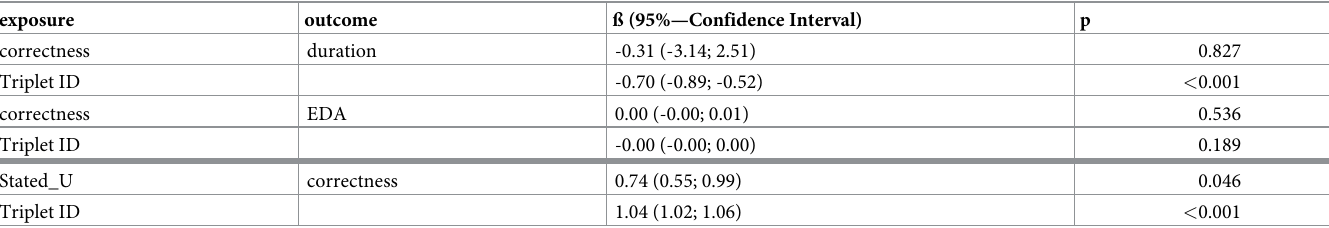
Table 10. Associations of correctness with duration, EDA and Stated_U. Associations were analyzed by mixed models with random intercept.